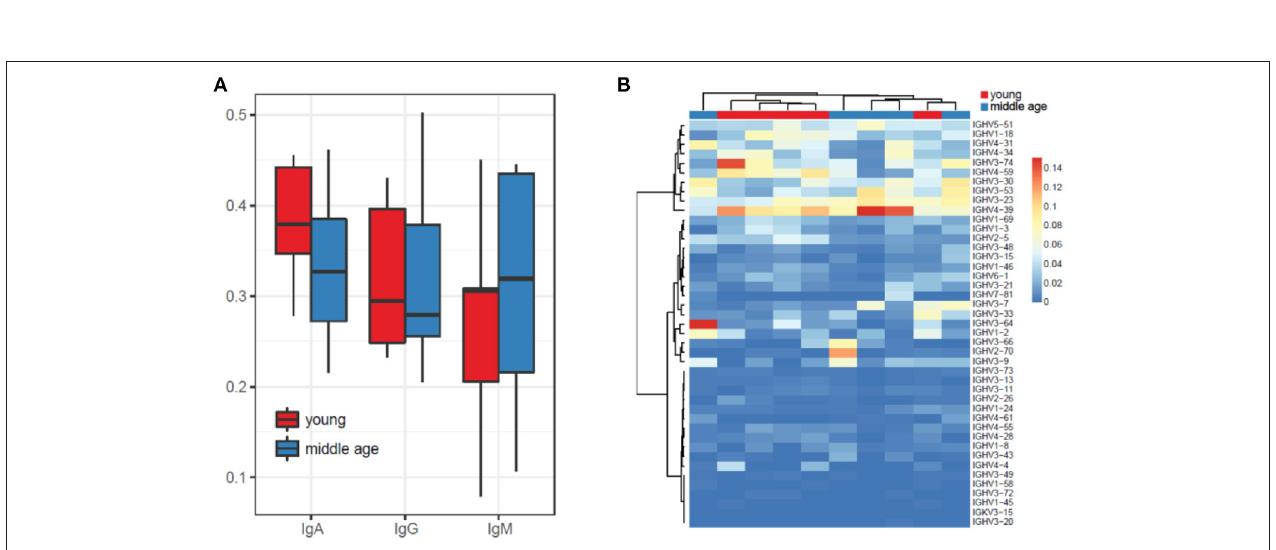
FIGURE 2 | Isotype and IGHV segments usage for YF-vaccinated subjects from the two age groups. (A) Isotype usage. (B) IGHV usage.